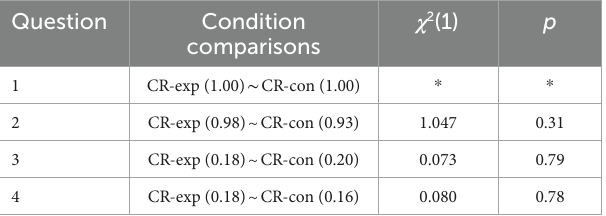
TABLE 1 Results involving a proportion of correct responses across different questions and conditions in task 1.